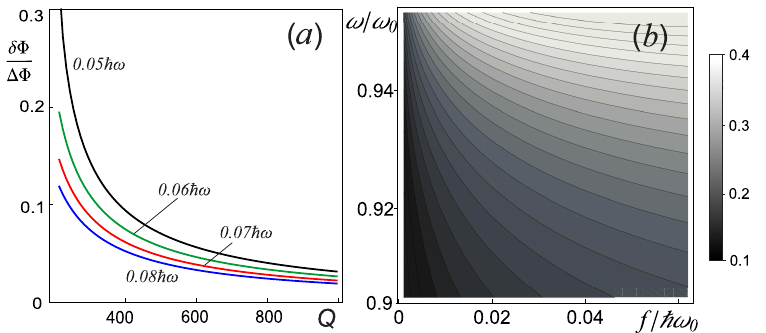
Figure 3. ( a ) The value of δ Φ / ∆Φ as the function of the quality factor Q of the nonlinear oscillator for different values of the drive current amplitude f : 0.05¯ h ω (black), 0.06¯ h ω (green), 0.07¯ h ω (red) and 0.08¯ h ω (blue). ( b ) The dependence of ∆ on the drive current f amplitude and frequency ω . Other parameters of the system are determined by the relations